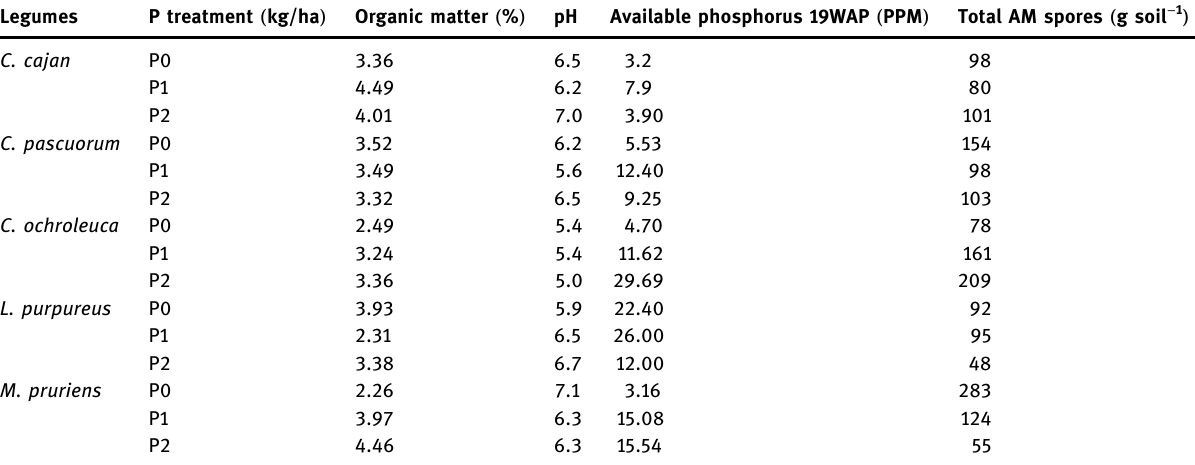
Table 1: Total counts of AMF spores in the soil of studied legume species and some physicochemical properties of soils Legumes P treatment ( kg/ha ) Organic matter ( % )